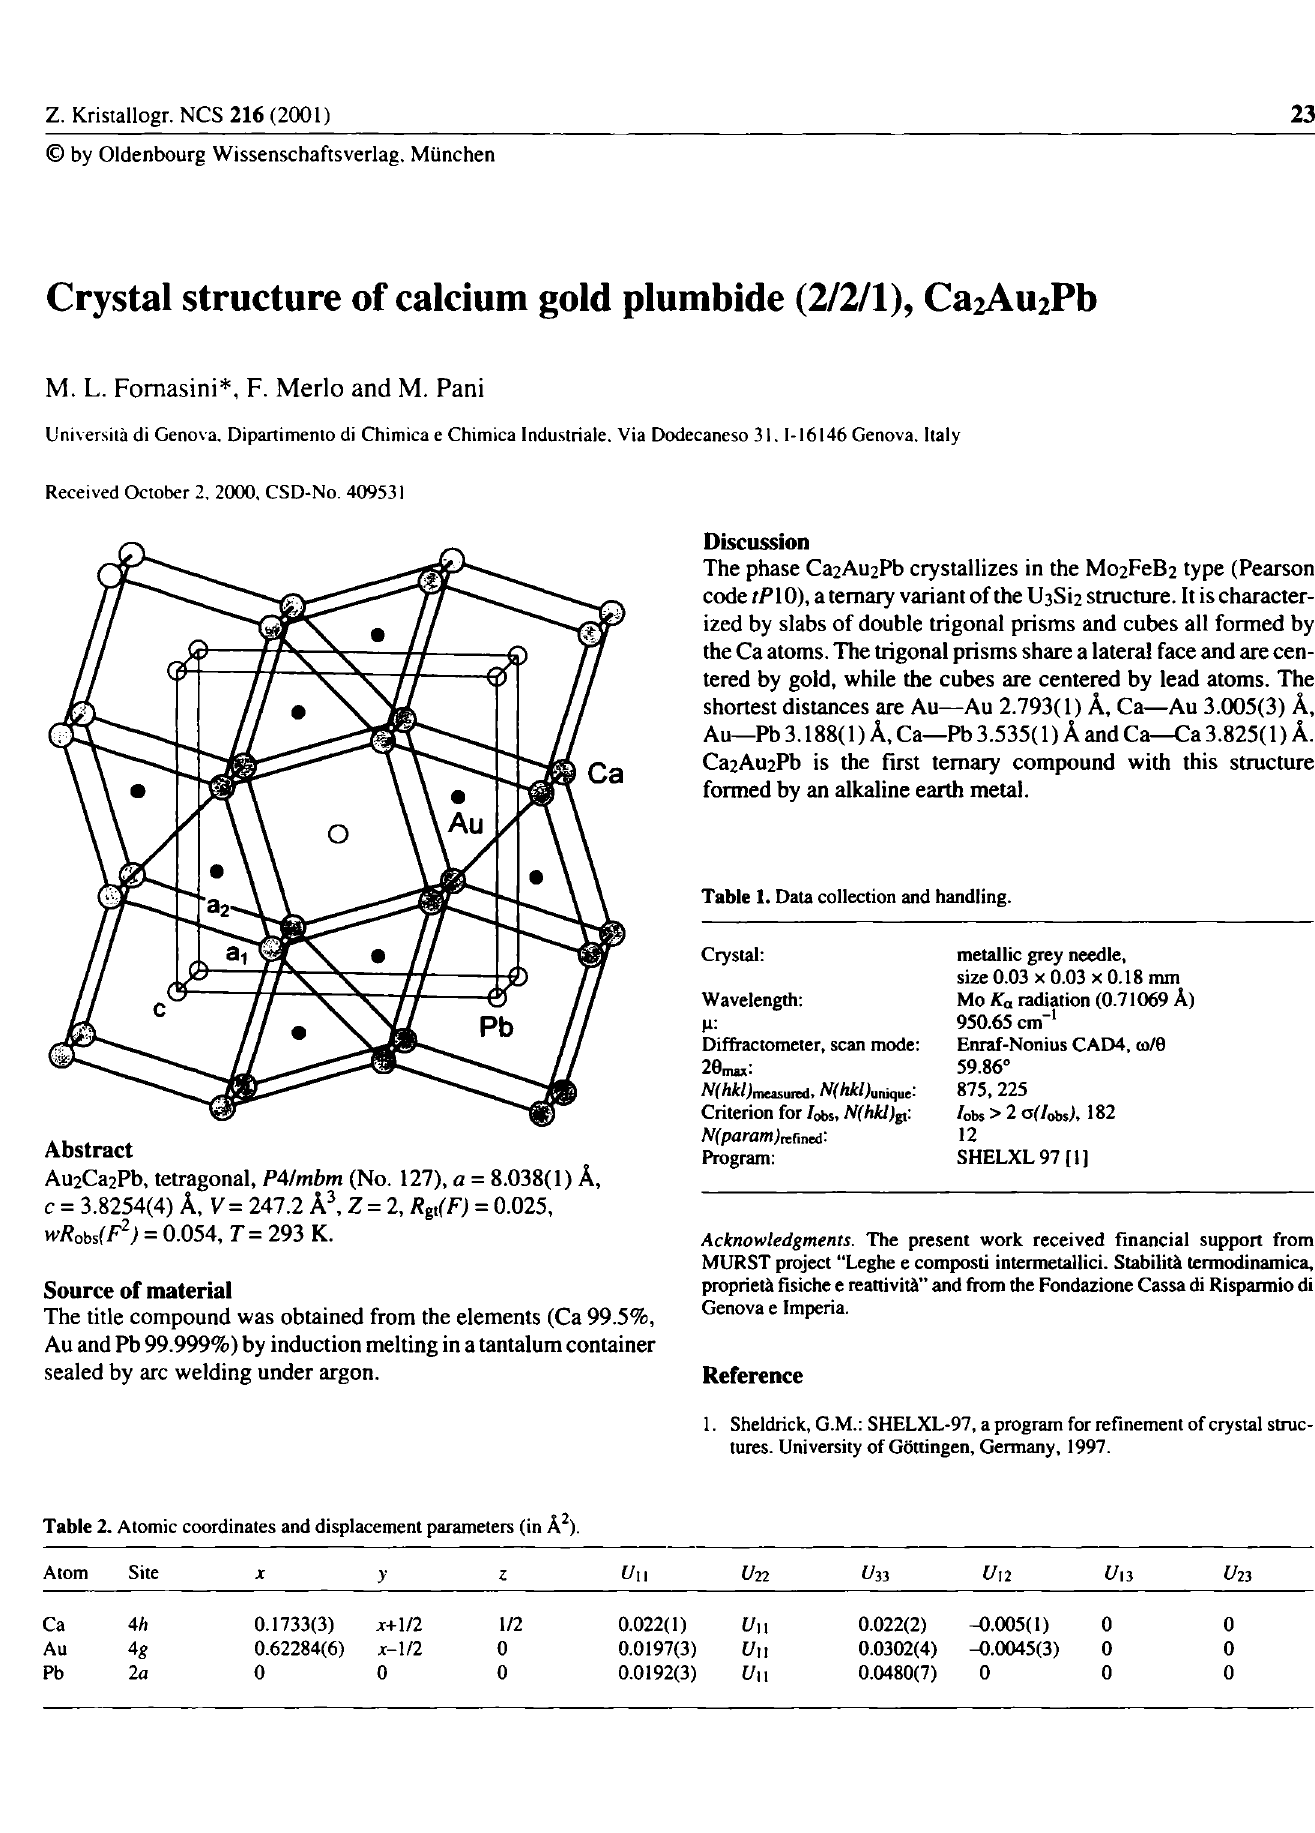
Table 2. Atomic coordinates and displacement parameters (in A 2 ).